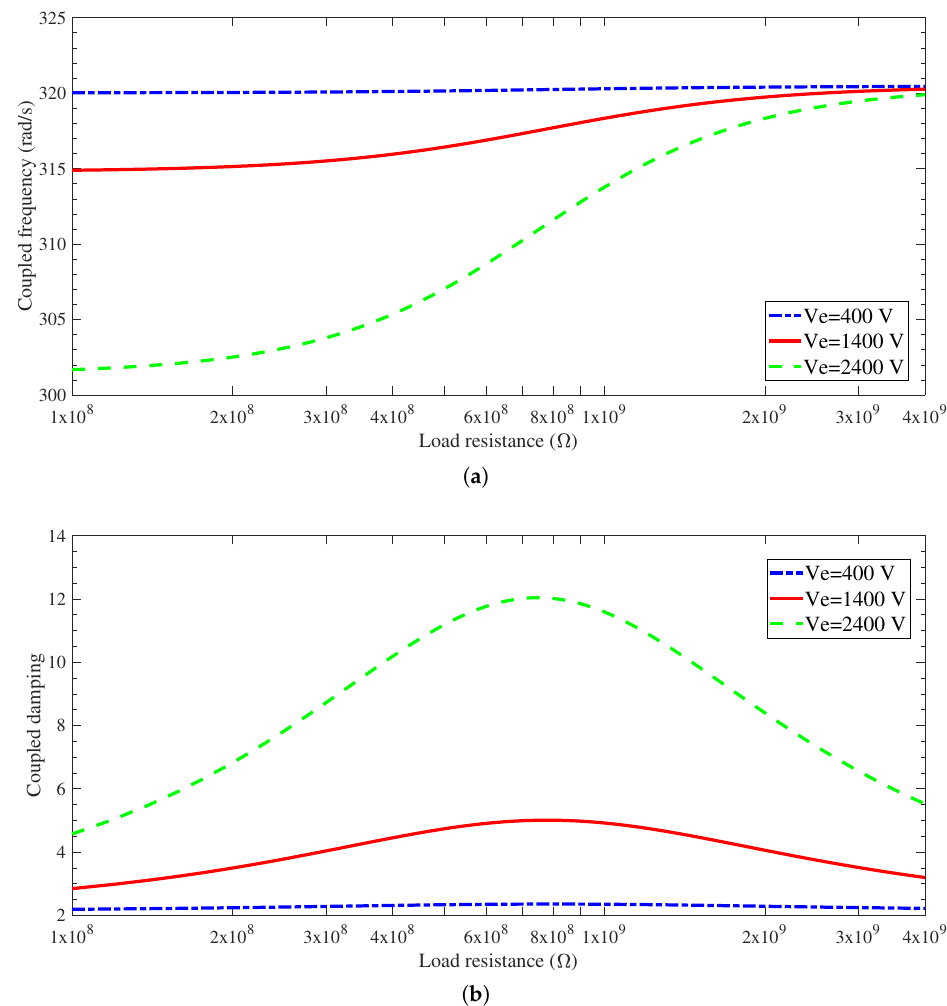
Figure 6. Variations of ( a ) the coupled frequency and ( b ) electromechanical damping as functions of the electrical resistance R l for different electret surface voltage V et